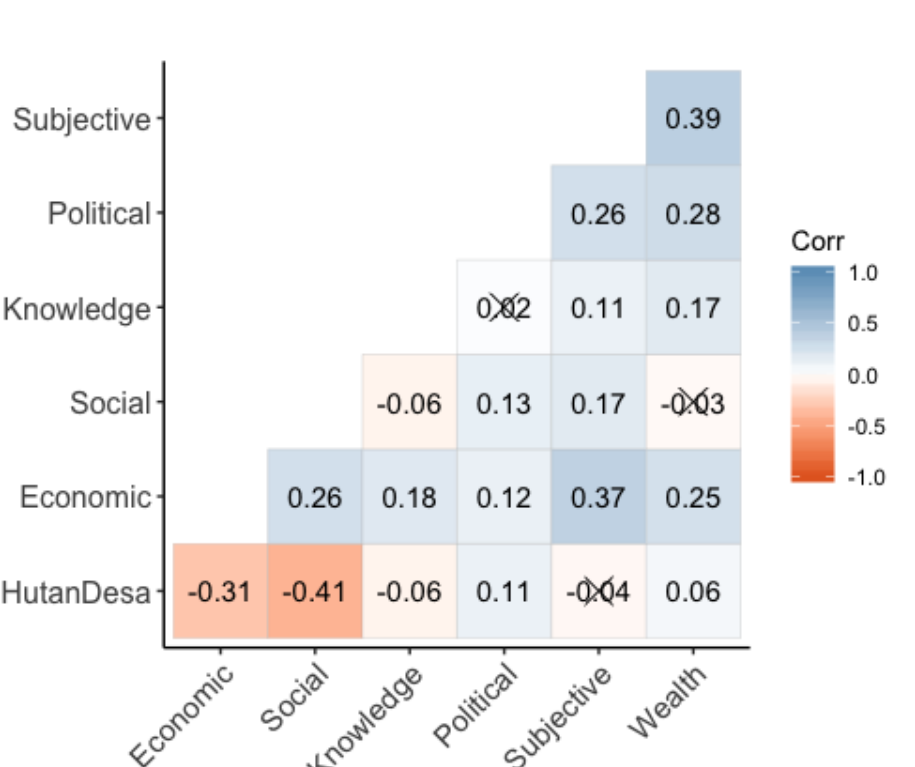
Figure A2.2. Correlation matrix to identify any existing relationships between Hutan Desa and wellbeing metrics that might have some bearing on participation or forest use. Knowledge, economic, and social wellbeing were all negatively correlated to Hutan Desa . Political wellbeing is positively correlated to Hutan Desa , which is reasonable considering it is calculated based on tenure and access to media